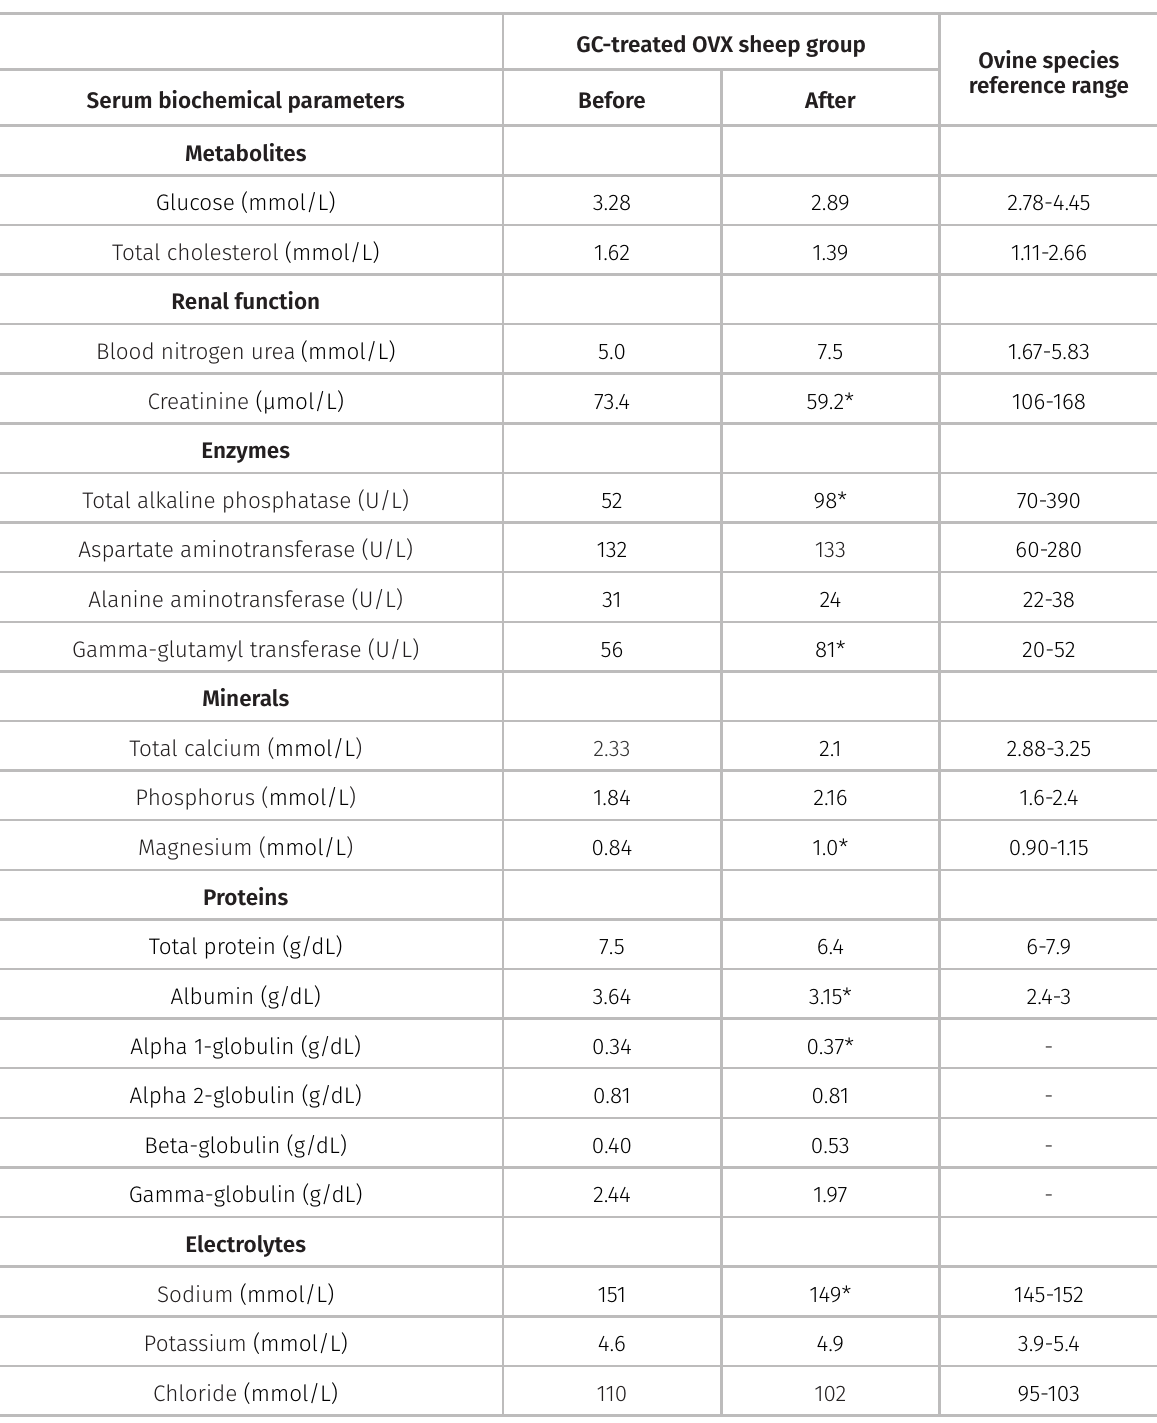
Table II. Serum biochemical parameters before and after OVX and exogenous GC administration in sheep (median values) and reported reference range for ovine species [reference intervals from Radostits et al. (2000); reference intervals of bone turnover markers from Dias et al. (2008), Kiełbowicz et al. (2015) and Camassa et al. (2017); reference interval of estradiol from Sigrist et al. (2007) and Kiełbowicz et al. (2015) (between